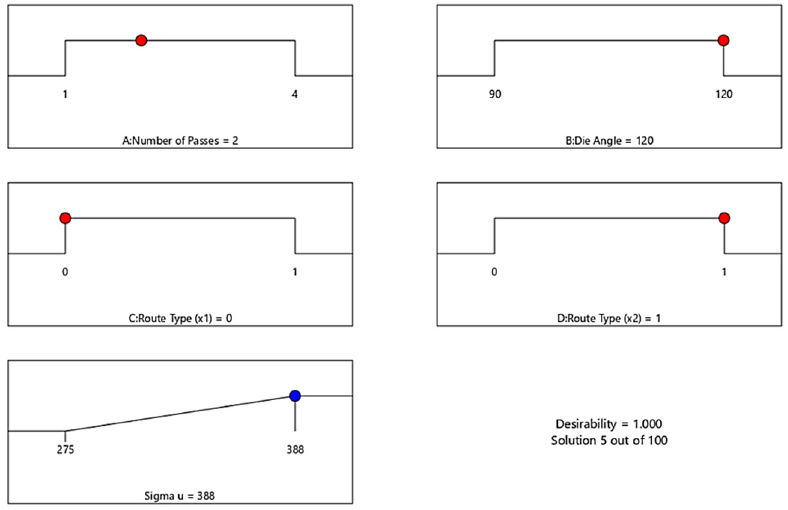
Figure 14. Optimal ECAP process parameter of σ u . Red dots: ECAP condition. Blue dots: ECAP response.